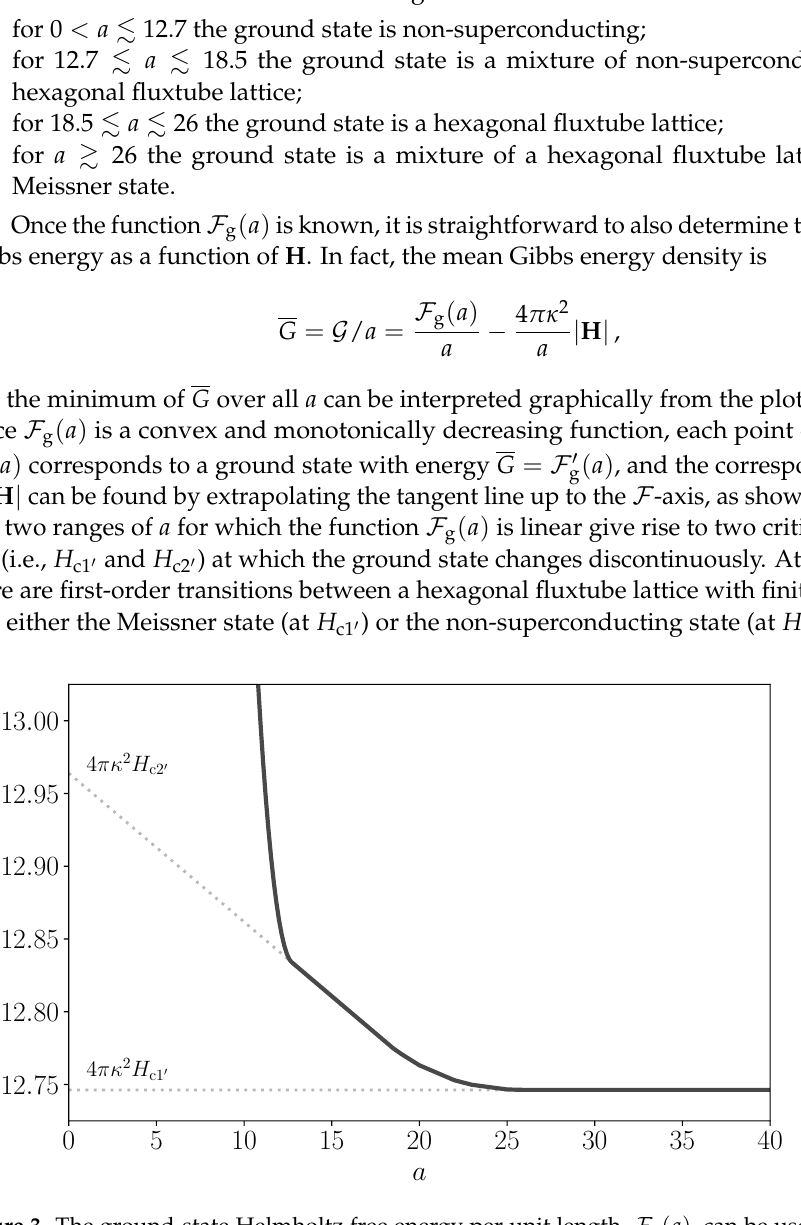
( a ) , can be used to infer the Figure 3. The ground-state Helmholtz free energy per unit length, F g minimum Gibbs free-energy density, G , as a function of the external field, H . The tangent to each ( a ) has slope G , and intersects the vertical axis at the point = 4 πκ 2 H point on the curve . The F g F | | dotted lines indicate the transitions at H c1 and H c2 , both of which are first-order in this example. We (cid:48) (cid:48) have used the same dimensionless parameters as for Figure